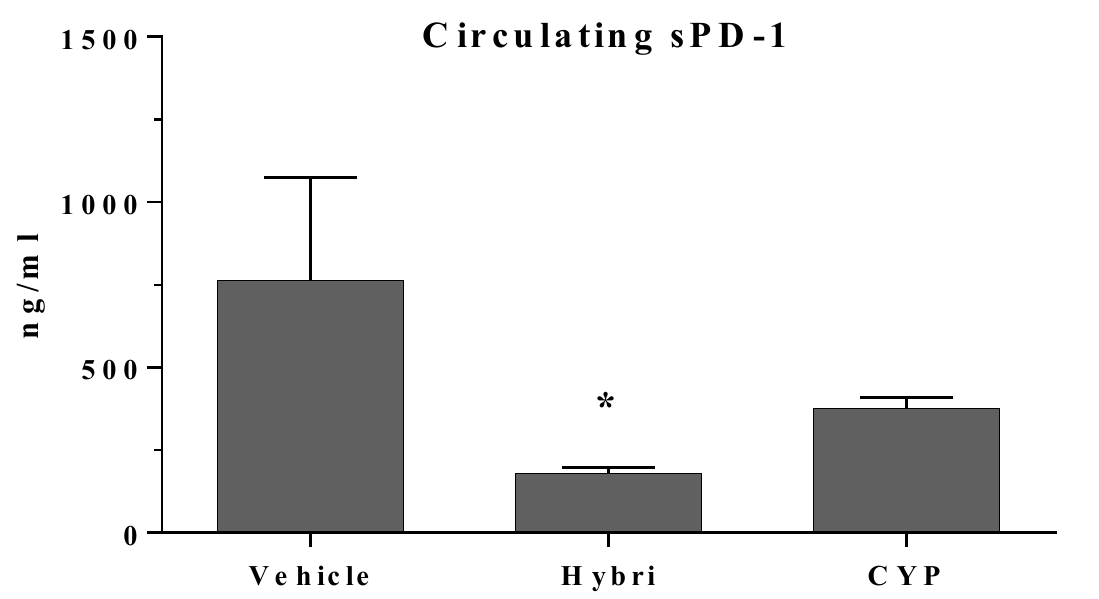
Figure 8. Circulating sPD-1 levels at the end of the study (week 22 of age) were diminished in MRL/lpr mice with Hybri administration. Serum levels of sPD-1 at the end of the second set of experiments in the MRL/lpr mice. Vehicle group: n = 5; Hybri group: n = 5; CYP group: n = 6. Values are expressed in ng/mL and presented as mean ± S.E.M. * p < 0.05 versus vehicle.